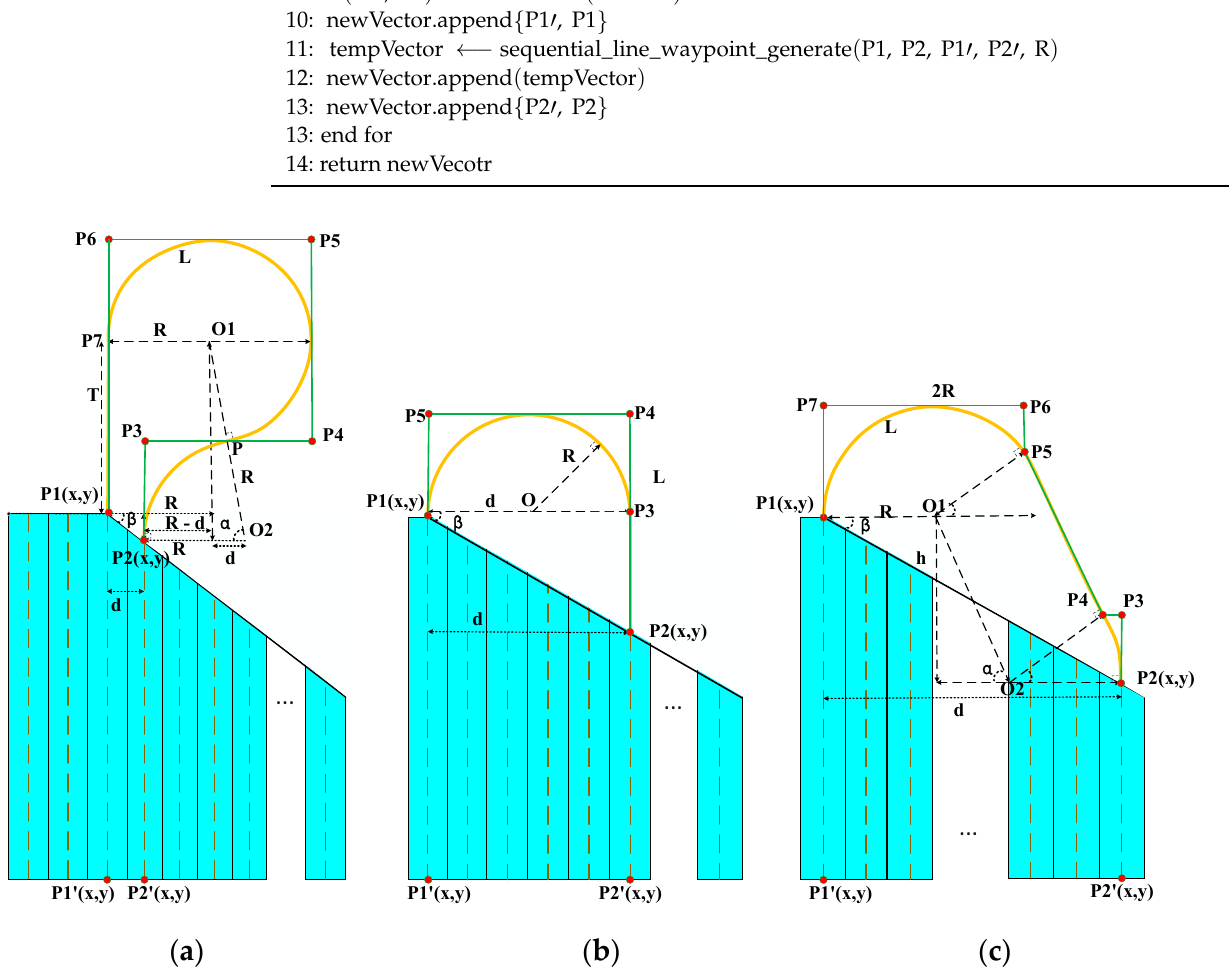
Figure 4. Waypoint generation under known trajectory: ( a ) span less than turning radius, ( b ) span equal to turning radius, and ( c ) span greater than turning radius. Ned2Geo converts the Ned (North East Down) coordinate system to the geographic coordinate System, Geo. Geo2Ned does just the